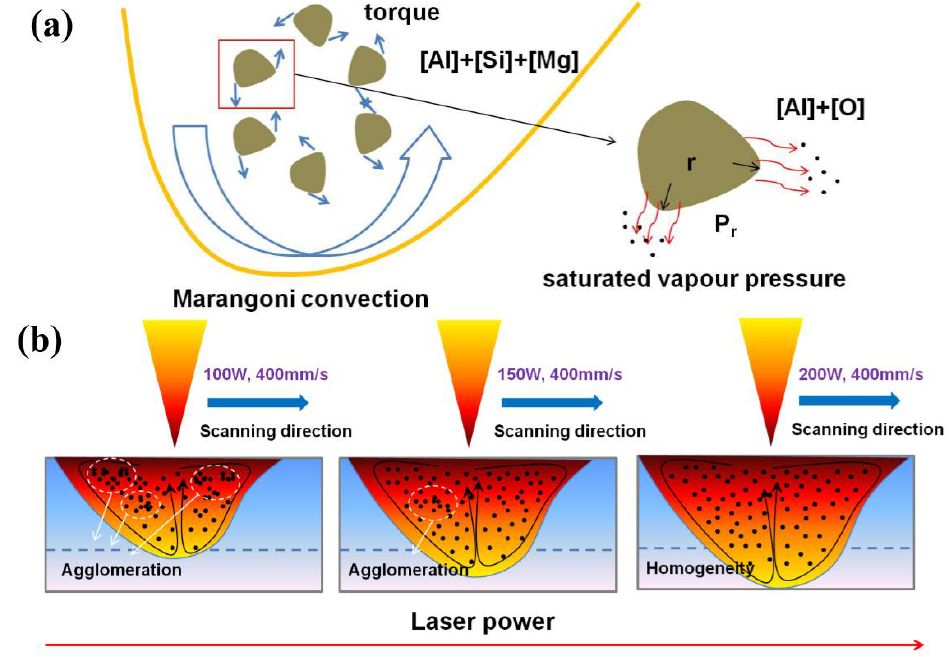
Figure 5. Schematic of the formation mechanism of the in situ Al 2 Si 4 O 10 phase ( a ) and particle distribution ( b ) during SLM processing. distribution ( b ) during SLM